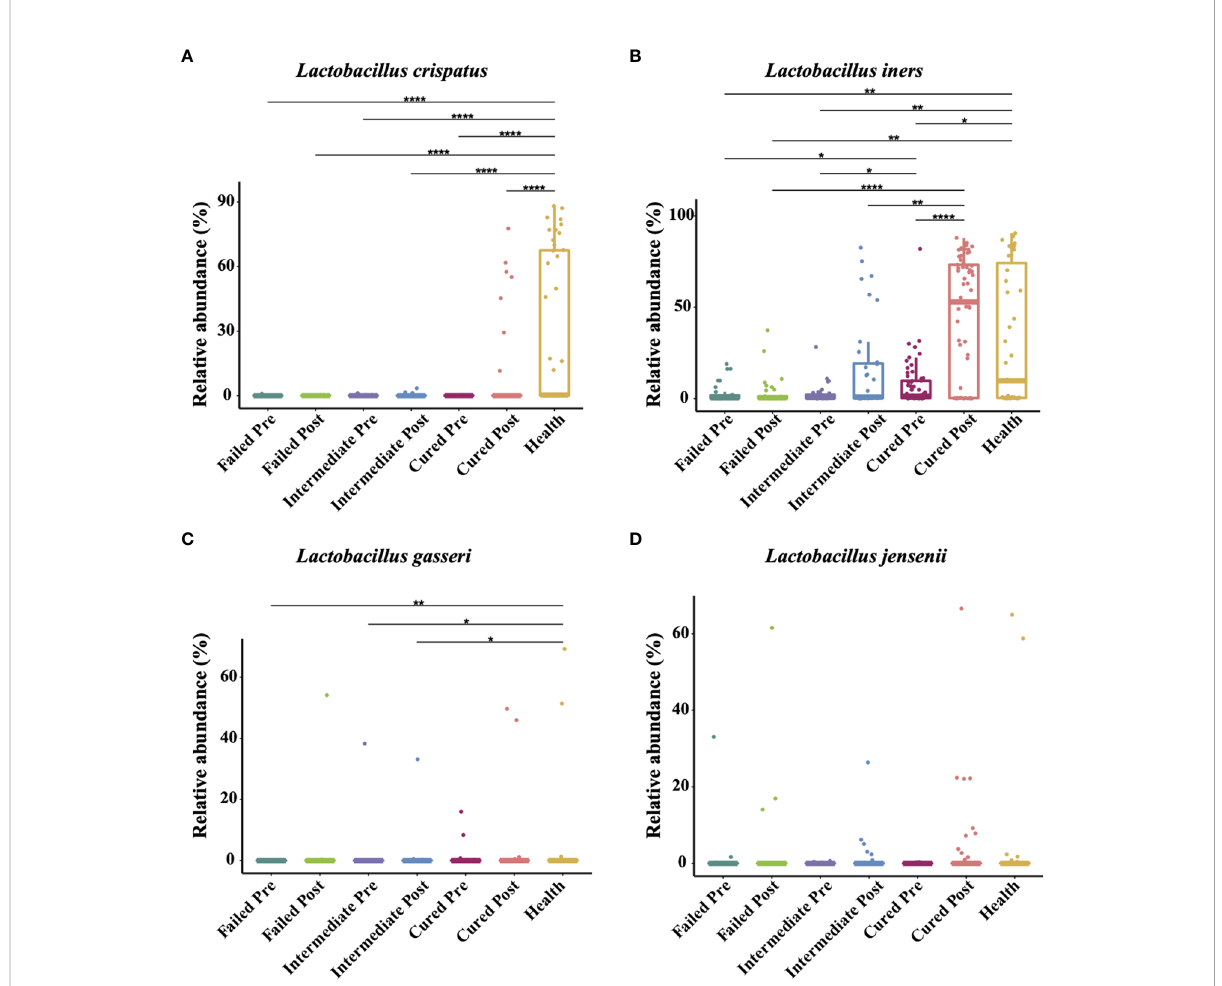
FIGURE 4 Comparison of four Lactobacillus species abundance in different groups. Intergroup comparison of the relative abundance of the four most abundant Lactobacillus species: L. crispatus (A) , L. iner s (B) , L. gasseri (C) and L. jensenii (D) . Only statistically signi fi cant P value that has clinical meaning is marked in the graph. Signi fi cance is exhibited as: *: p<0.05; **: p<0.01; ***: p<0.001; ****: p<0.0001; Wilcoxon test for pairwise comparison between pre- and posttreatment and Kruskal-Wallis test for comparisons among different